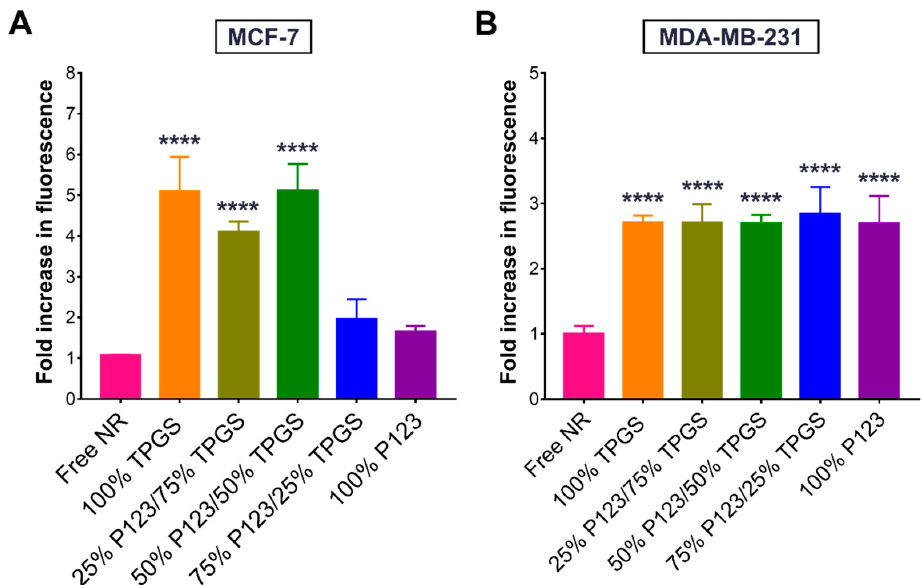
Figure 12. Normalized fluorescence intensities (mean ± SD; n = 3) of ( A ) MCF-7 and ( B ) MDA-MB- 231 cells treated with free NR or NR-labeled NPs for 1 h. **** p < 0.0001 based on one-way ANOVA followed by Tukey’s multiple comparison test.